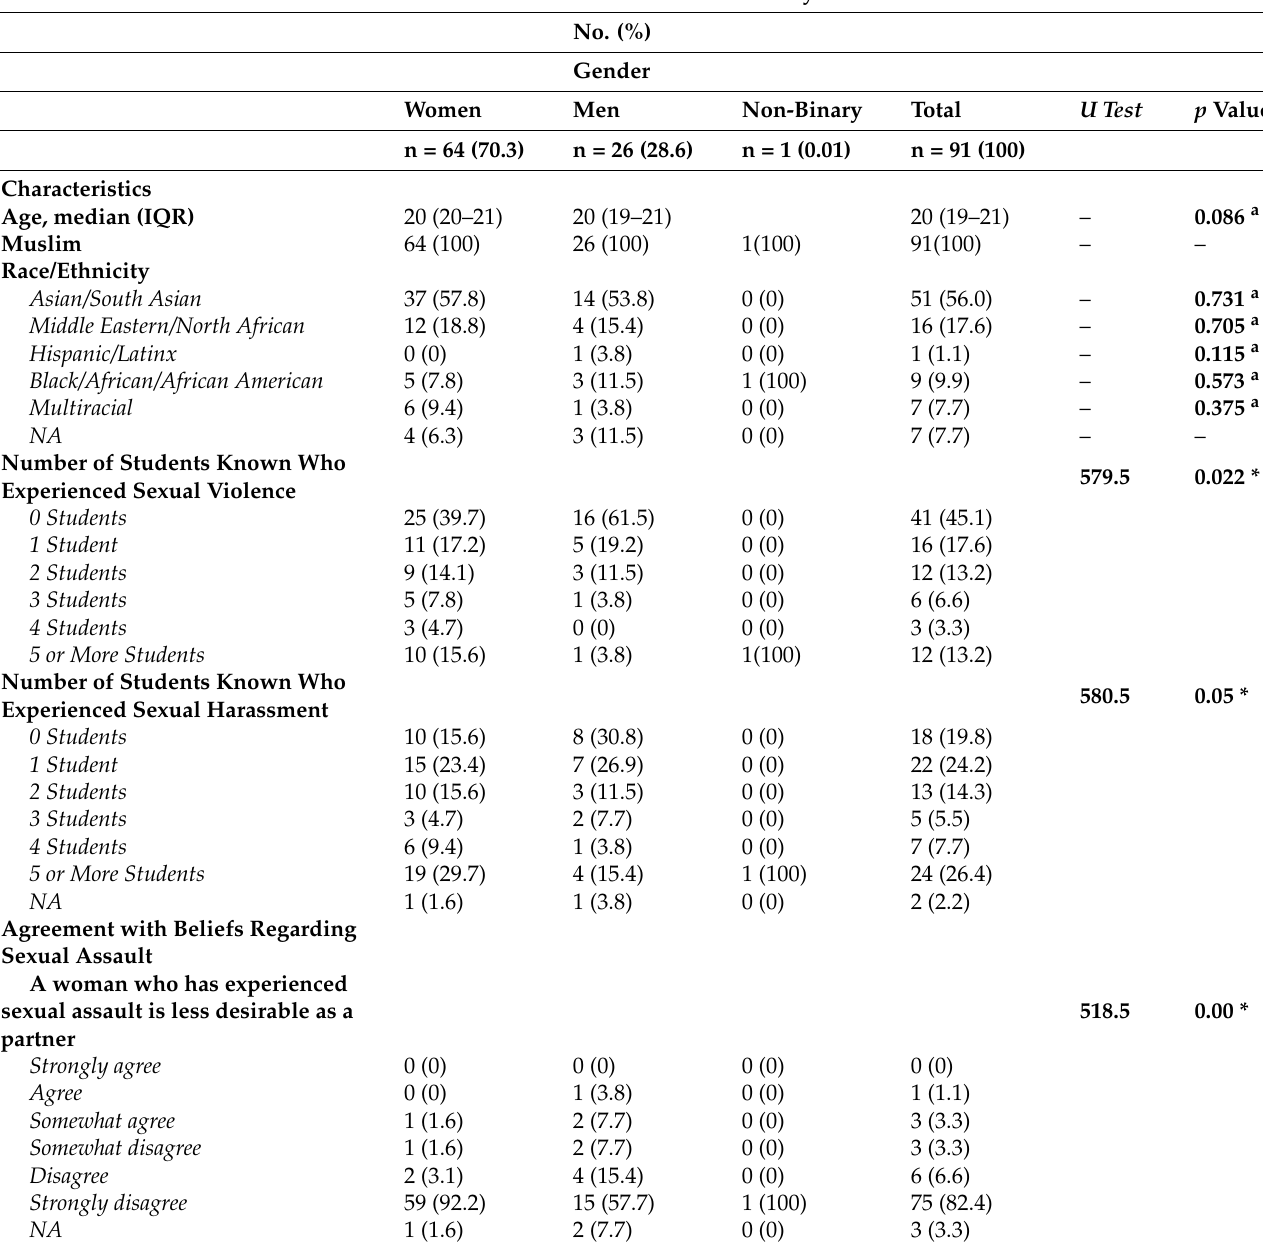
Table 2. Sexual Violence Awareness and Beliefs by Gender. Sexual Violence Awareness and Beliefs by